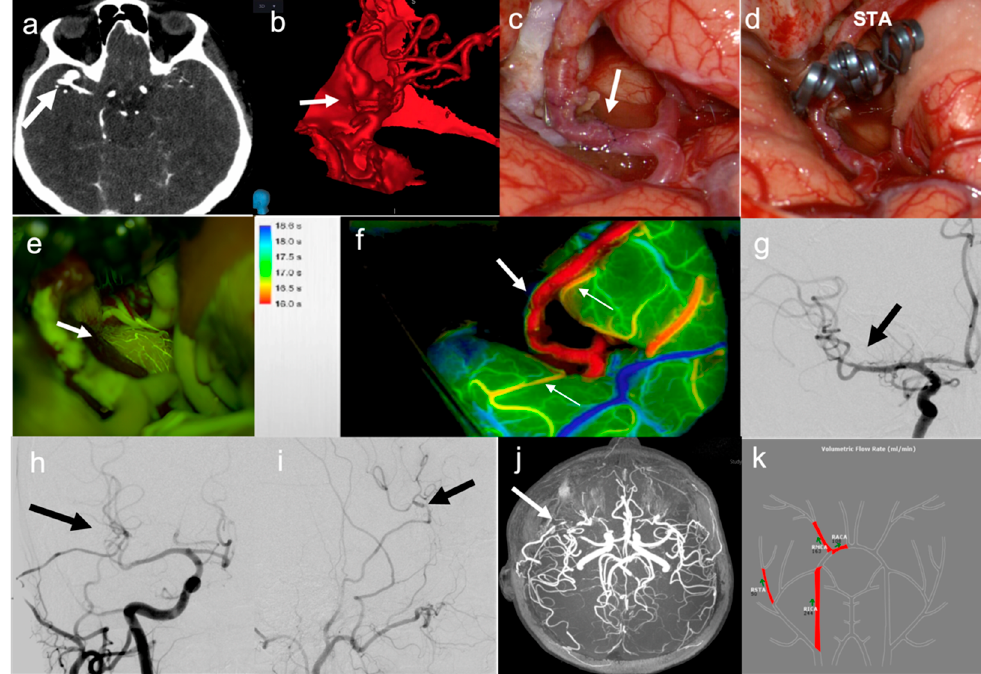
Figure 1. Illustrative case of “Complex” aneurysms with only surgical treatment (bypass and trapping): ( a ) CT-angio showing M2 trifurcation aneurysm (arrow); ( b ) 3D reconstruction of aneurysm (arrow); ( c ) Intraoperative view of STA–MCA bypass (arrow); ( d ) Intraoperative view of aneurysm trapping; ( e ) Intraoperative SF-VA showing the patency of the bypass with an adequate parenchymal perfusion as detectable by the visualization of small cortical vessels; ( f ) FLOW800 analysis showing bypass patency (large arrow) and fronto-temporal branches perfusion (thin arrows); ( g ) Postoperative DSA showing aneurysm exclusion (arrow); ( h , i ) Postoperative DSA showing STA–MCA bypass patency in frontal and lateral view (arrow); ( j ) Follow-up Angio-MRI showing bypass patency; ( k ) NOVA MRI showing a good arterial flow.